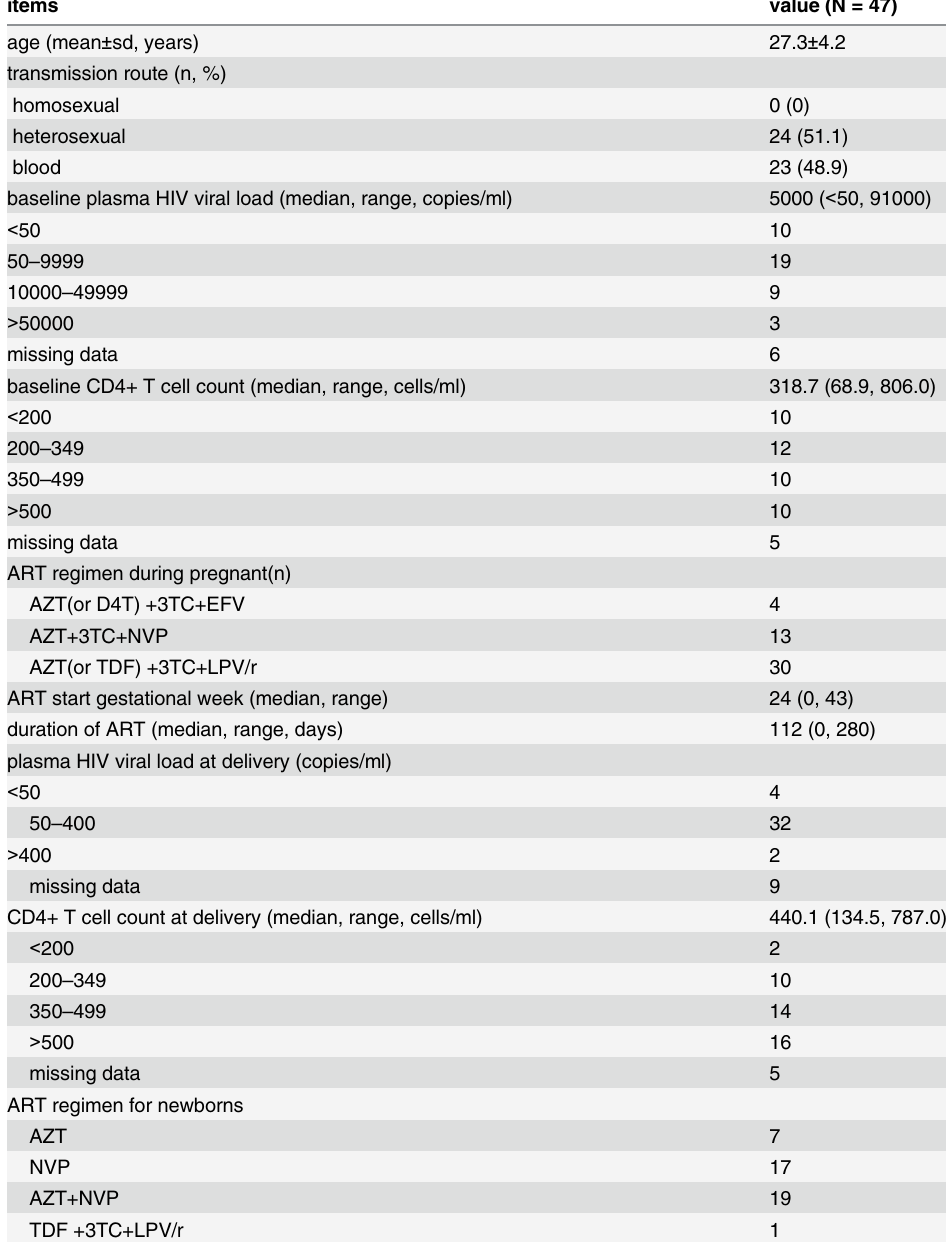
Table 2. The baseline characteristics of HIV positive women with male HIV negative partners. items value (N =